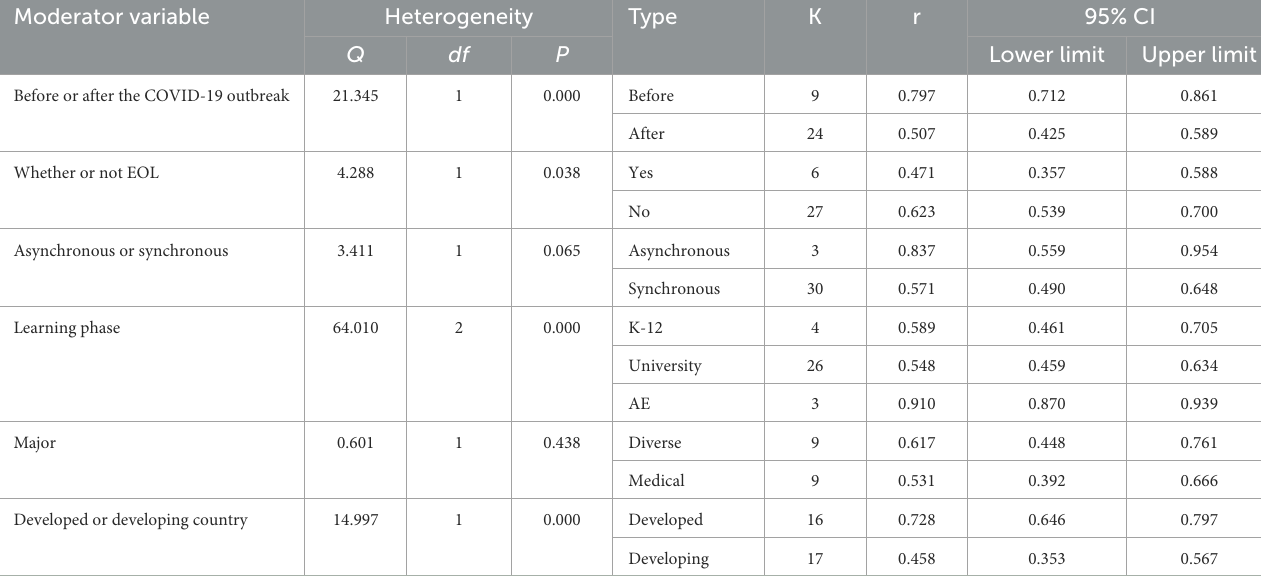
TABLE 6 Moderator analysis for student satisfaction.